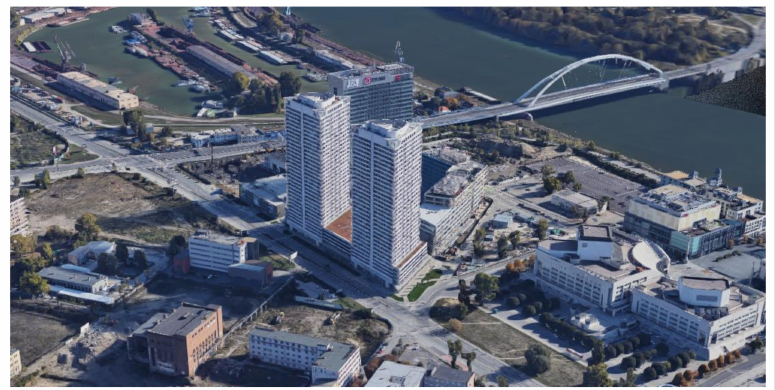
Figure 16. Complex of buildings from northwest view: Panorama City and Tower 115